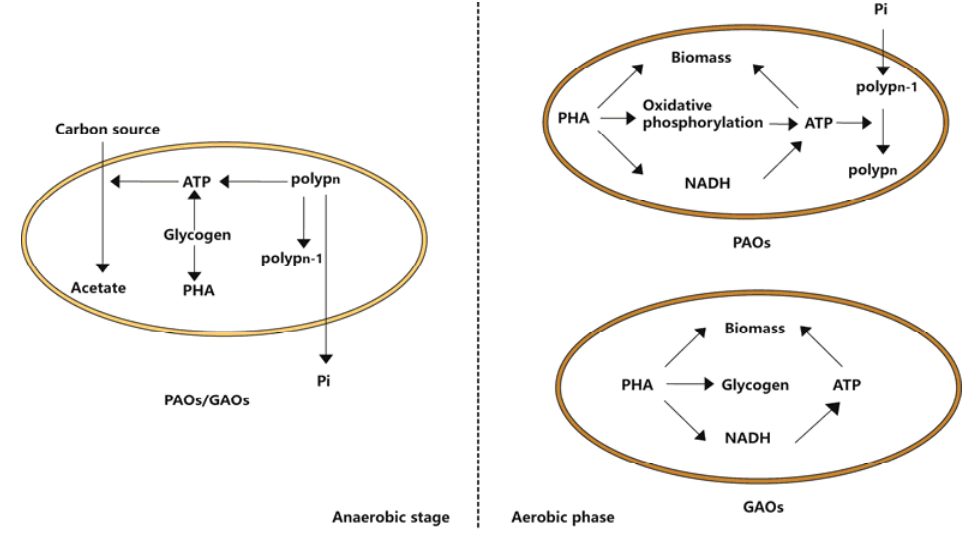
Figure 2. Anaerobic/Aerobic metabolism model of PAOs/GAOs.